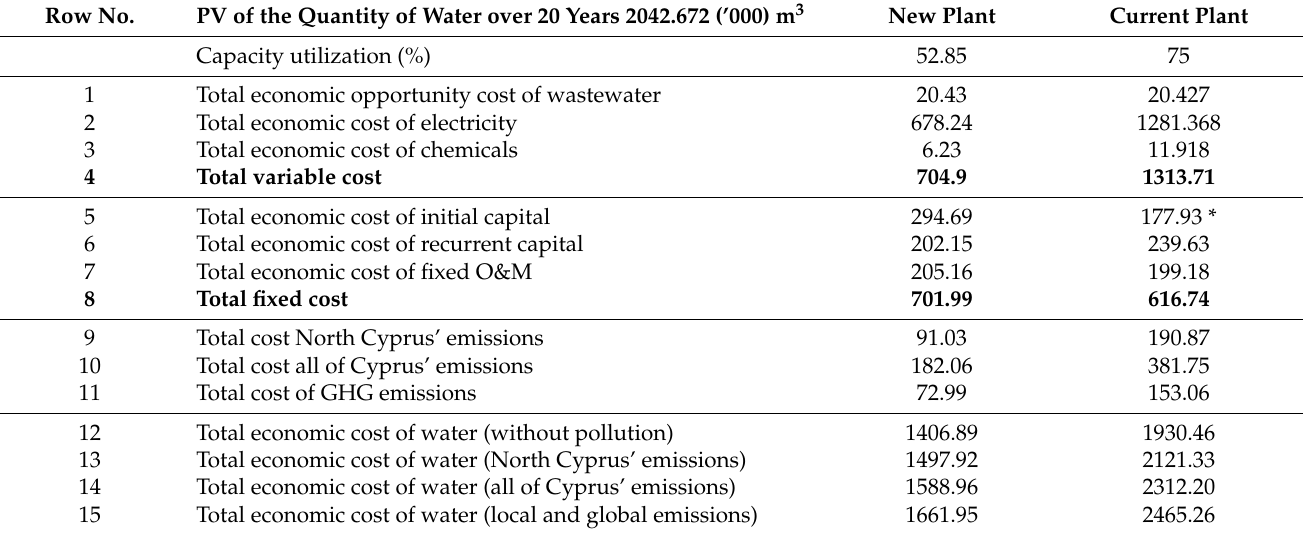
Table 11. Present value at 8% of the total economic costs for different capacity utilizations with emissions, in USD